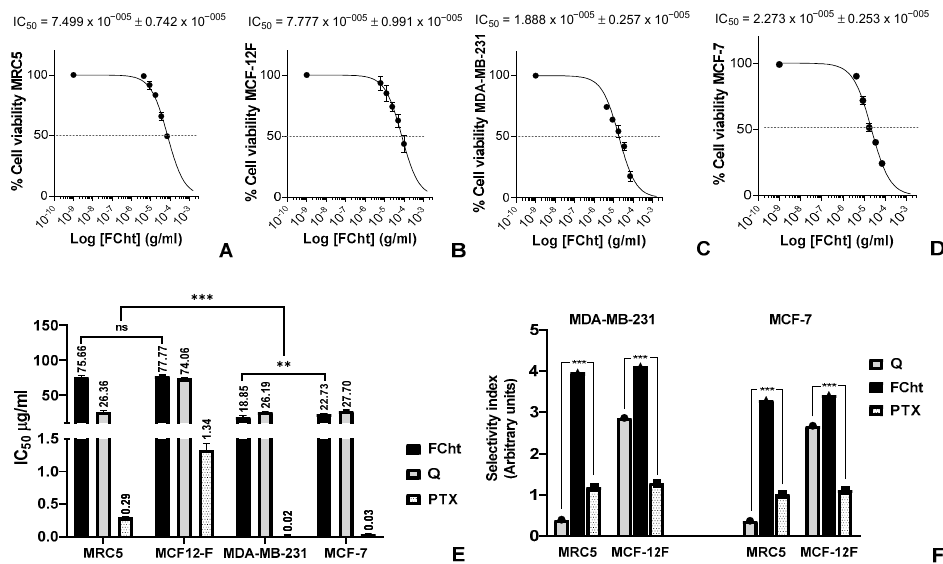
Figure 2. Cytotoxic activity and selectivity of Tacotanina on BC cells. ( A ) MRC5, ( B ) MCF12-F, ( C ) MDA-MB-231, ( D ) MCF-7, ( E ) half-maximal concentration (IC 50 ), and ( F ) selectivity index on BC cells. Three independent experiments, each performed in triplicate were carried out and data were analyzed in GraphPad Prism 8.0, (La Jolla, CA, USA). p -values indicate statistical significance (** p < 0.05 or *** p < 0.001).